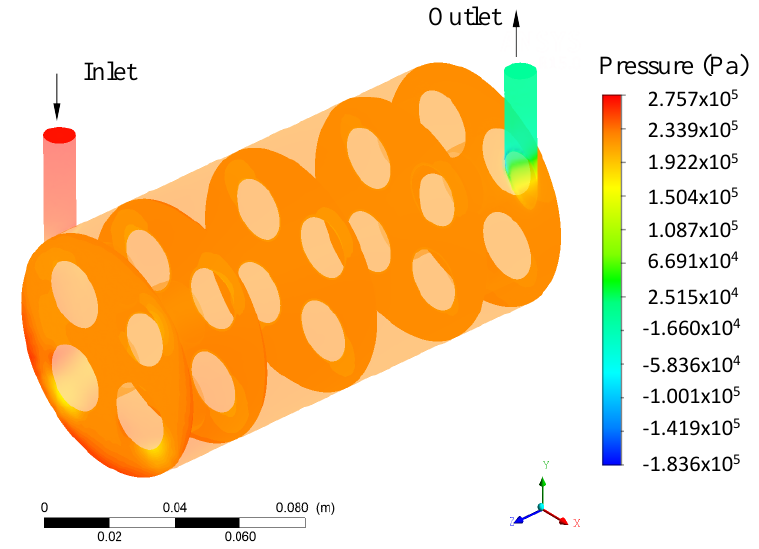
Figure 7. Pressure distribution in the hull Figure 7. P ressure distribution in the hull region..